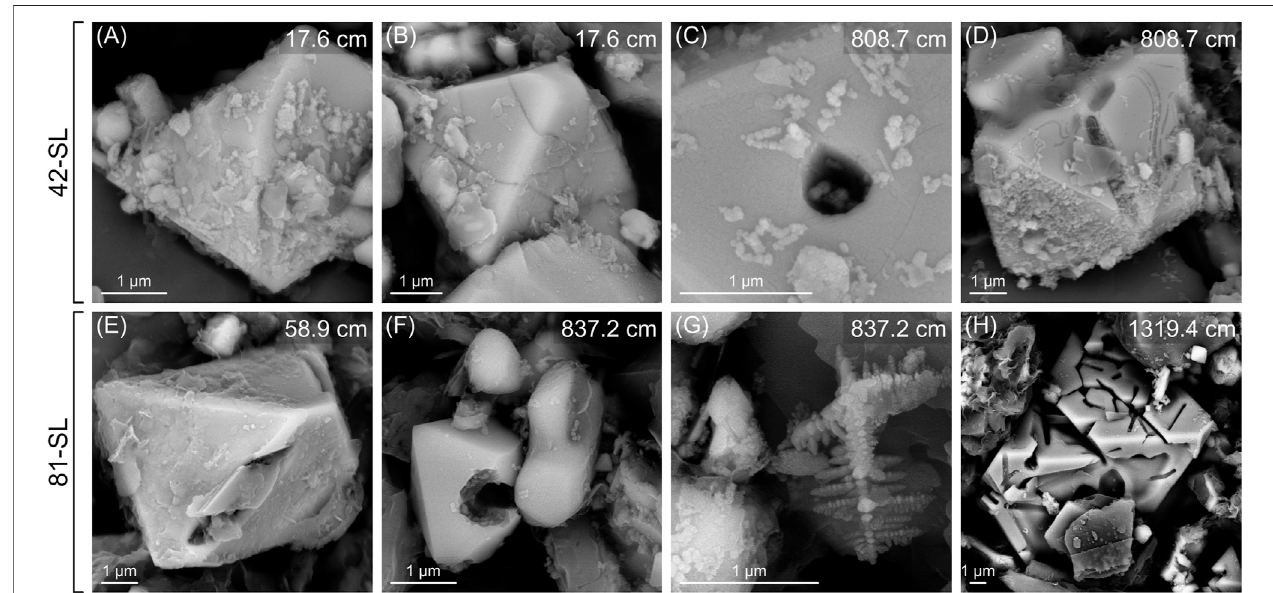
FIGURE3| SelectedSEMbackscattermicrographsofmagneticextractsof42-SLand81-SLsamples. (A,F) Titanomagnetitecrystalswithattachedmagnetofossil chains. (B) Maghemitizedtitanomagnetitewithshrinkagecracks. (C) Octahedralmagnetofossilchainsontitanomagnetitecrystal.Titanomagnetitecrystalswithcomplex etch marks (H,D) and adhering biogenic magnetite (D) . (E) Titanomagnetite partially covered with a fi lamentous layer of manganese oxide. (G) Isolated magnetite dendrite.